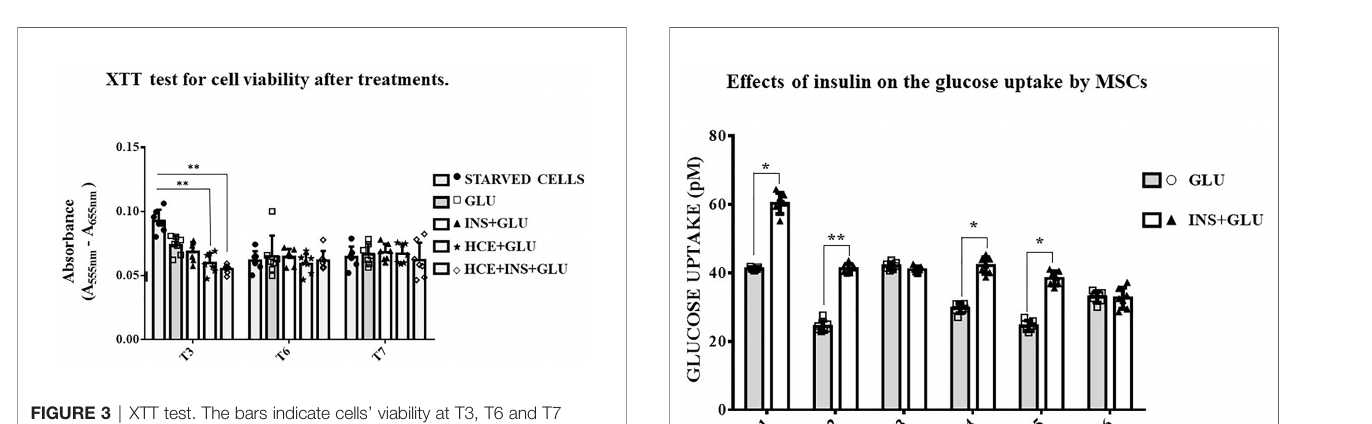
FIGURE 3 | XTT test. The bars indicate cells ’ viability at T3, T6 and T7 sampling times. One-way ANOVA; **p < 0.01 vs STARVED CTRL inside each time sampling. STARVED CTRL: cells continuously cultured in starvation medium; GLU: Cells exposed to glucose; INS+GLU: Cells stimulated with insulin before glucose exposure; HCE+GLU: HCE (Higher and Constant Exposure) cells treated with glucose; HCE+INS+GLU: HCE cells stimulated with insulin before glucose exposure. Data are expressed as mean ± SD of the absorbance read for MSCs derived from each single patient over three independent experiments.